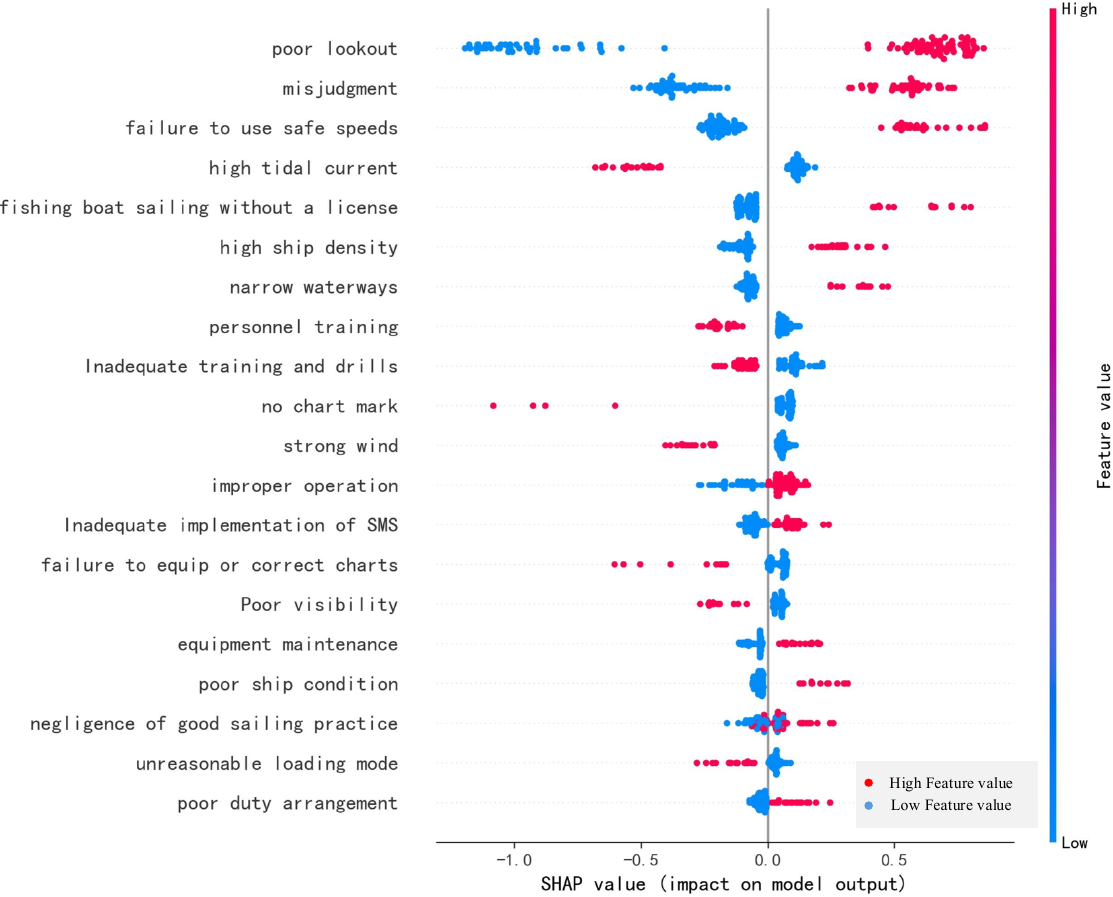
Figure 10. Scatter diagram of the comprehensive influence of the factors on ship collisions.